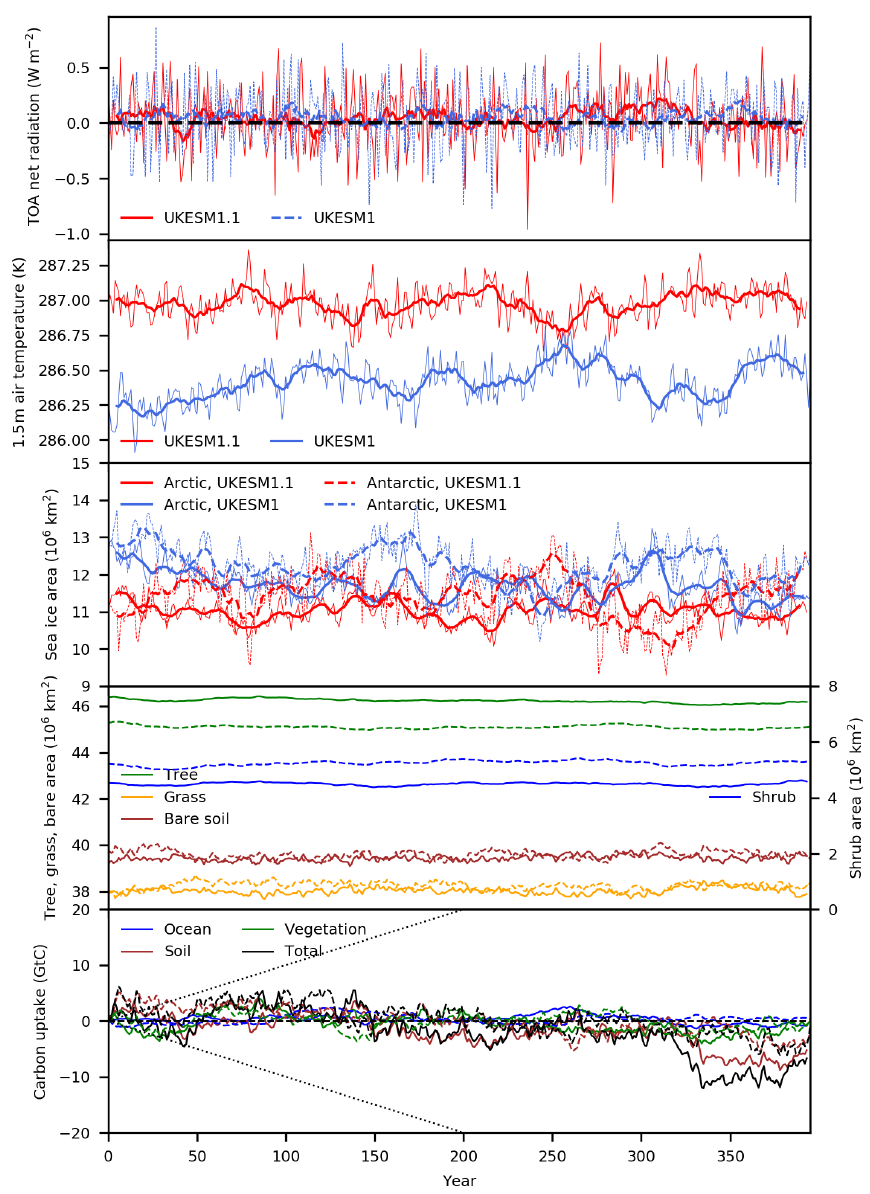
Figure 1. Time series of preindustrial climate properties from UKESM1 and UKESM1.1. Plotted from top to bottom are the global annual mean net TOA radiation, global annual mean 1.5m air temperature, annual mean Arctic and Antarctic sea ice area, global total area of aggregated plant functional types (solid lines for UKESM1.1; dashed lines for UKESM1) and cumulative carbon uptake (solid lines for UKESM1.1, dashed lines for UKESM1 and the dashed black line depicts acceptable drift, following Jones et al., 2016). In the top three panels, UKESM1.1 is plotted in red, and UKESM1 is plotted in blue. An 11-year running mean is plotted with the thicker